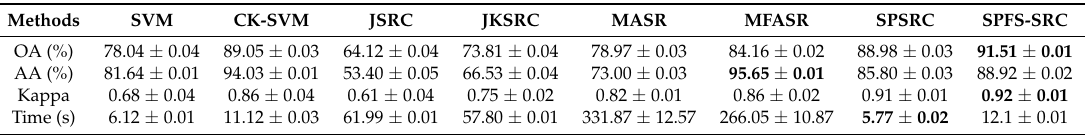
Table 3. Classification results from different approaches for the PaviaU dataset with 20 training samples per class (Best result of each row is marked in bold type).